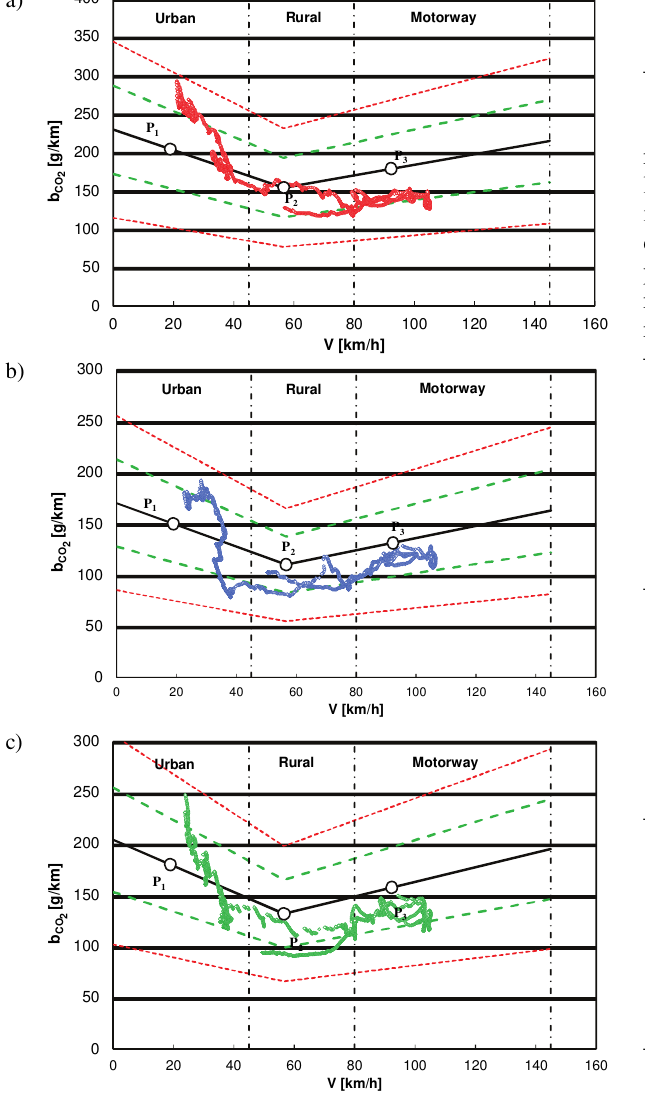
Fig. 14. The carbon dioxides characteristic curves: a) Gasoline, b) Diesel, c)